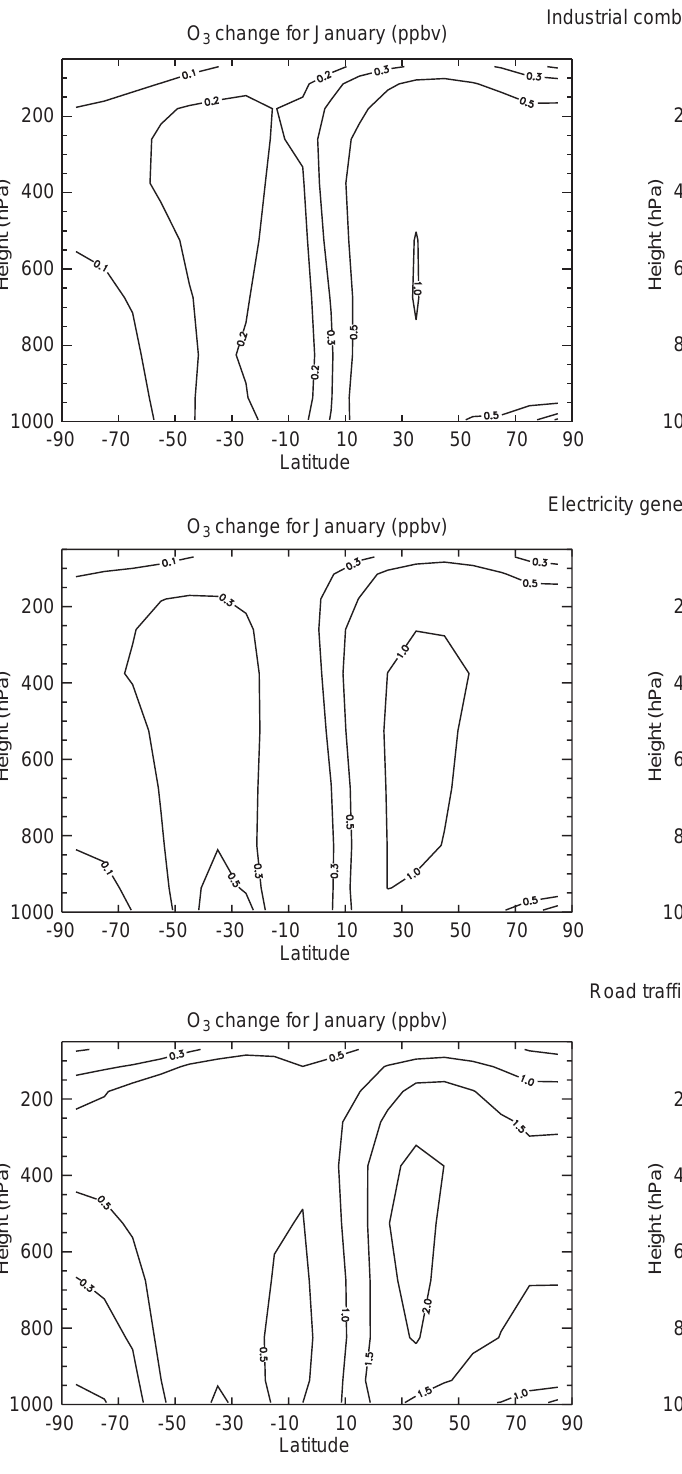
Fig. 7. Contribution of to the NO emissions from industrial ozone concentration due to aircraft emissions are shown in Fig. 4). x combustion, electricity generation and road tra(cid:129)c to the zonally- Figures are for January and July averaged ozone concentrations for the year 1990 (the changes in the